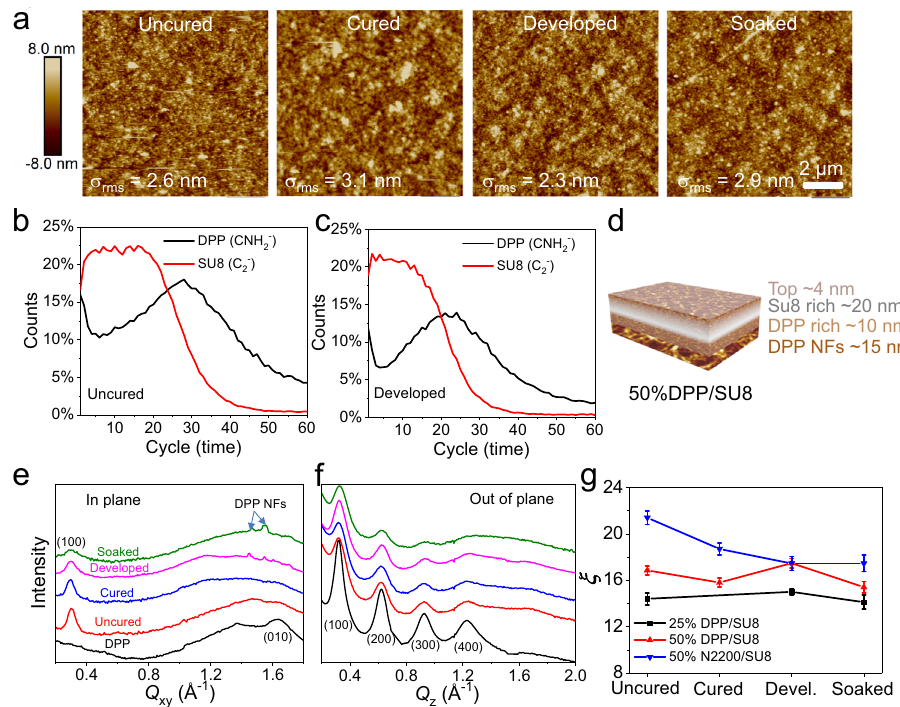
Fig. 2 Characterization of materials phase separation processes enabling transistor fabrication for high-resolution patterned ultra fl exible soft matter electronic circuitry. a AFM images of a 50% DPP/SU8 fi lms at different stages of the photolithographic process, demonstrating excellent chemical resistance. The ToF-SIMS depth pro fi les for b uncured and c developed 50% DPP/SU8 fi lms. d Schematic of VPS in uncured 50% DPP/SU8 fi lms into SU-8 rich, DPP-rich, and DPP nano fi bers, based on the AFM and ToF-SIMS characterization. e In-plane and f out-of-plane GIWAXS line cuts of the indicated 50% DPP/SU8 fi lms. g Coherence lengths ( ξ ) derived from out-of-plane (200) re fl ections for DPP/SU8 and in-plane (100) re fl ections for 50% N2200/ SU-8 after the indicated processing conditions. The error bars provide the standard polymers perform the best. Details of the semiconductor blend fi lm deposition, curing/patterning, and OTFT fabrication pro-